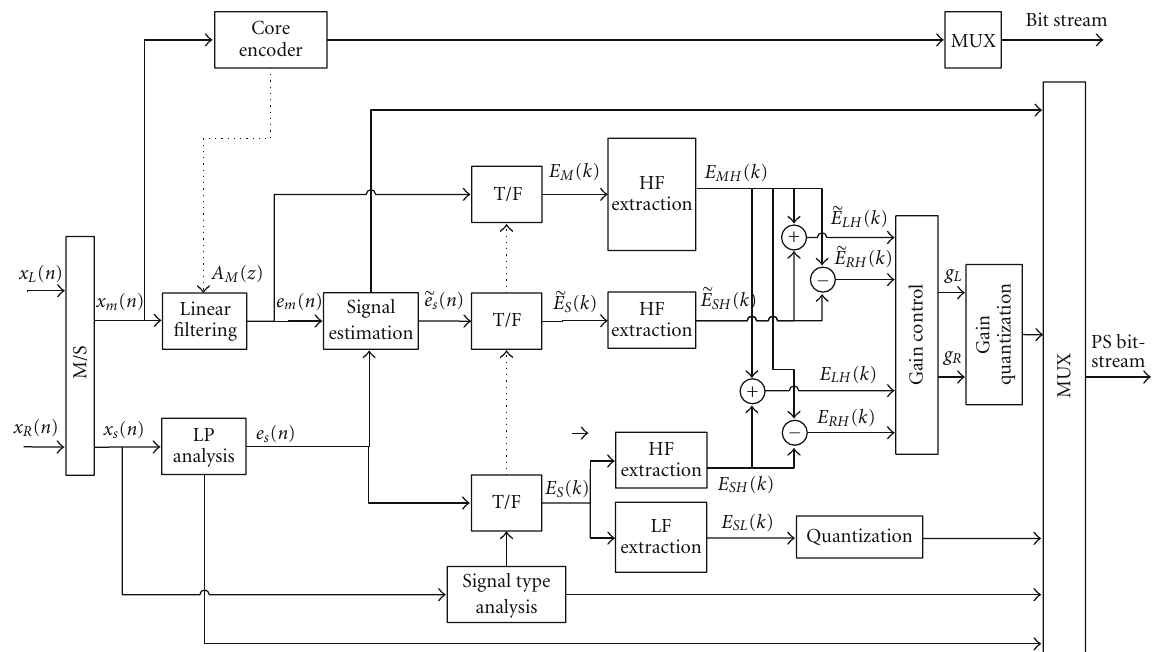
Figure 9: Stereo signal encoding